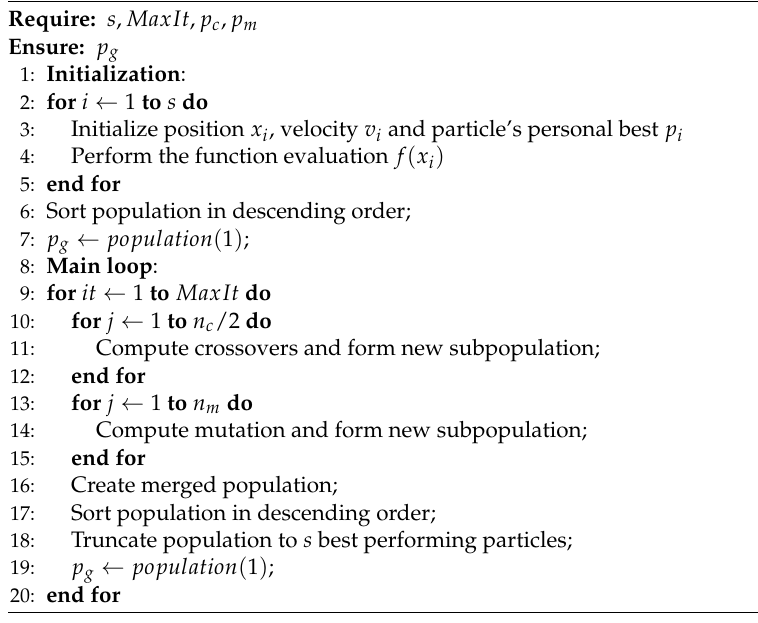
Algorithm A4 GA